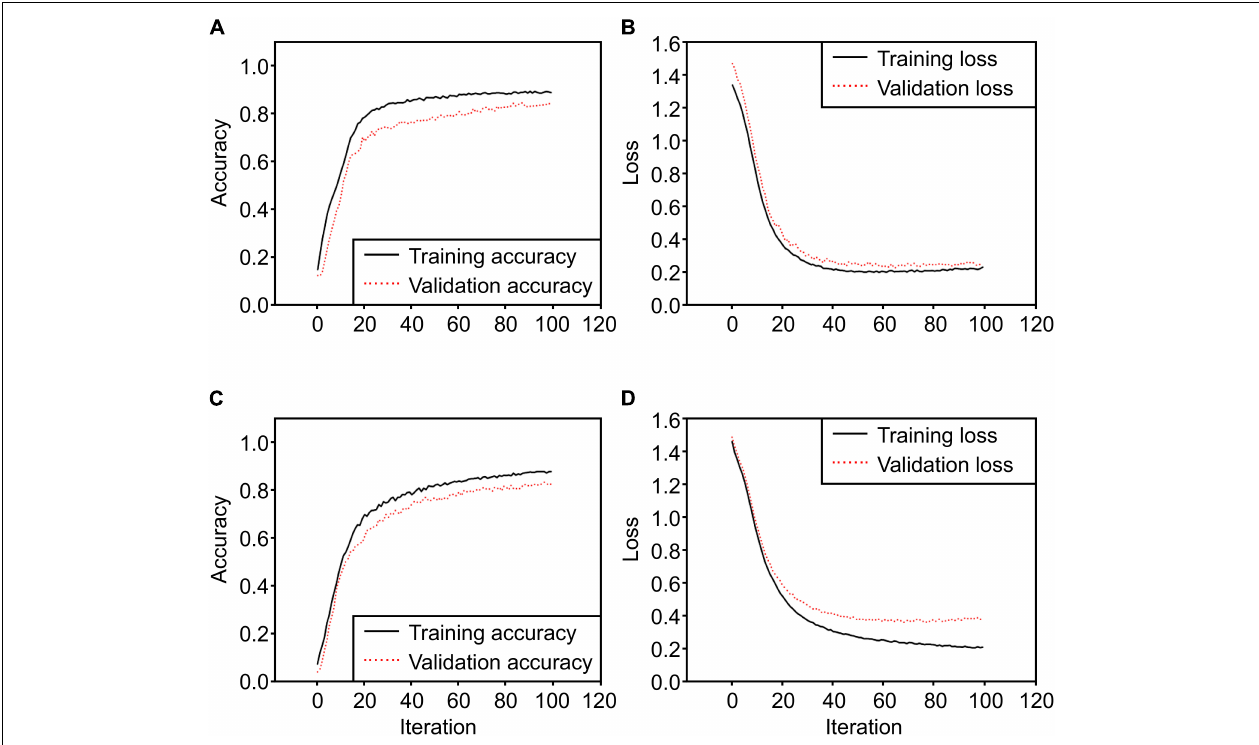
FIGURE 13 | 3D CNN model training results [ (A) training accuracy of the 3D CNN model proposed in this study, (B) loss of 3D CNN model, (C) accuracy of 3D CNN model using extended input, (D) loss of 3D CNN model using extended input].